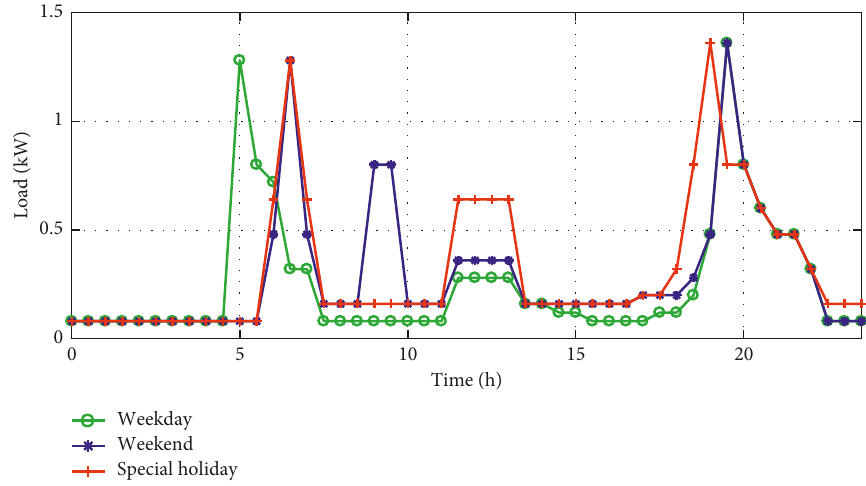
Figure 5: Developed load profile for a weekday, weekend, and special Table 2: Time-based tariff structure for domestic users. Time period (h)